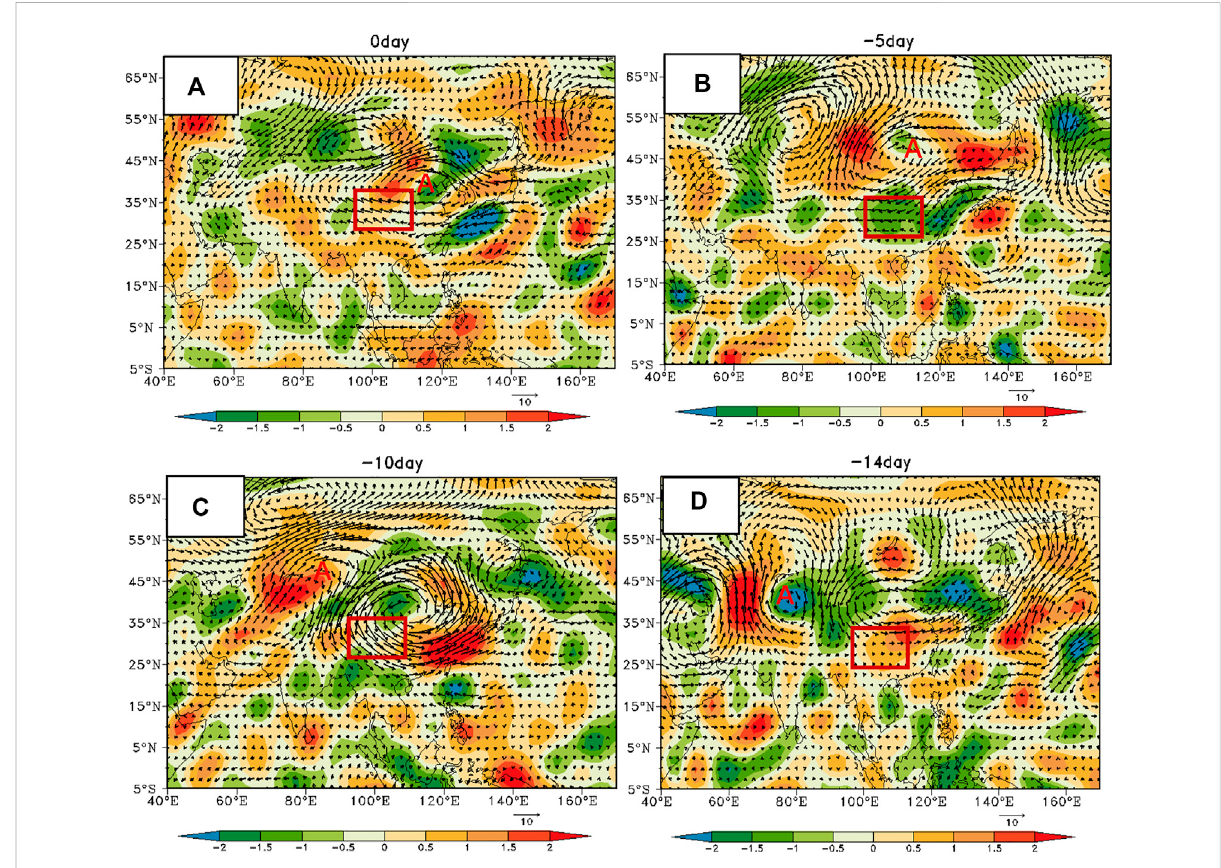
FIGURE 13 Evolution of the low-frequency (15 – 30 days) divergence (shading, unit: 10 − 6 S − 1 ) and wind (vector, unit: m/s) fi eld at 200 hPa from 14 days before the precipitation to 0 day after onset in the Basin